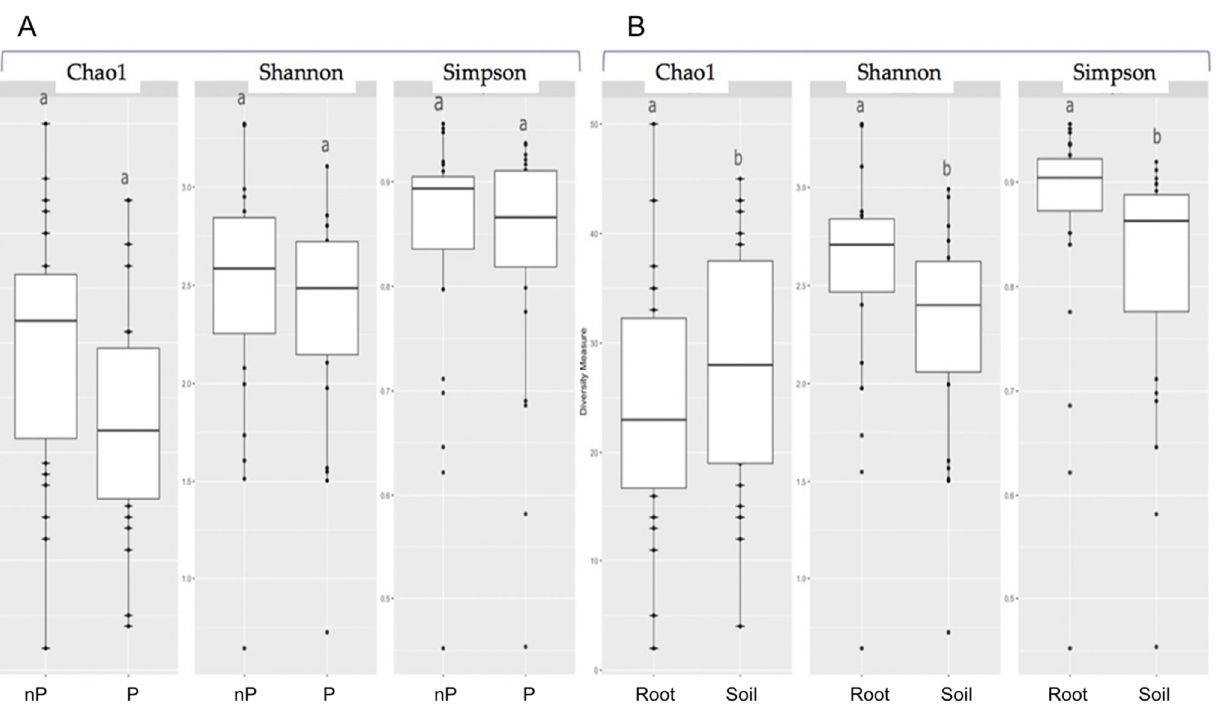
Figure 2. Richness (Chao 1 estimator) and diversity (Shannon and Simpson) indexes comparing AMF communities of ( A ) P versus nP soils, root and soil data being pooled; ( B ) root versus rhizospheric soil samples, P and nP site data being pooled. Within each graph, different letters denote significant differences using the Kruskal–Wallis nonparametric test ( p <